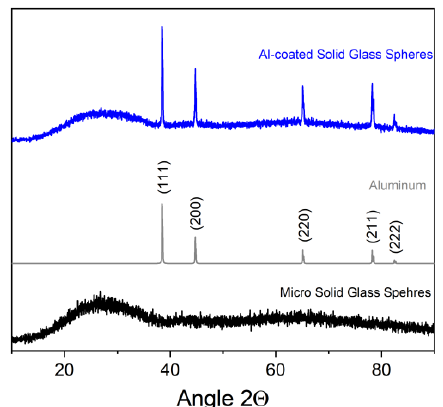
Figure 5. Qualitative comparison of X-Ray Diffraction of uncoated and LPD-coated Type S spheres. Besides the characteristic halo of amorphous materials, all characteristic peaks of metallic aluminum are detected on the coated spheres.